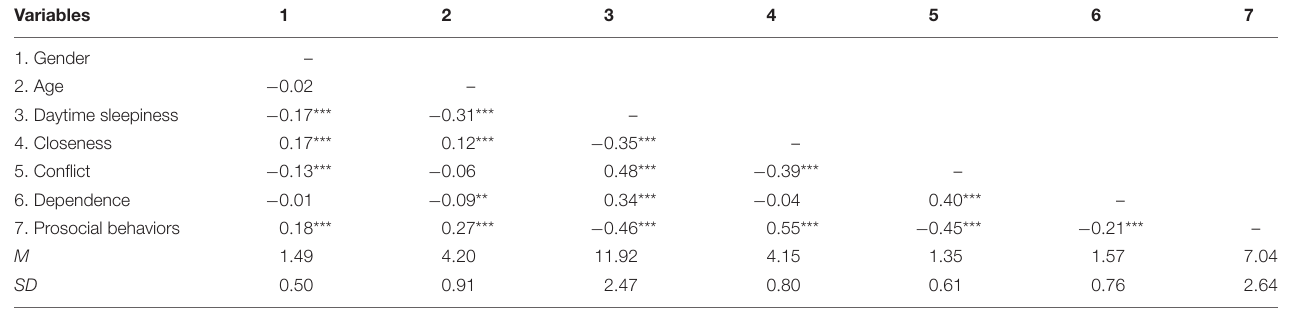
TABLE 1 | Means, standard deviations, and correlations of the variables ( N = 936). Variables